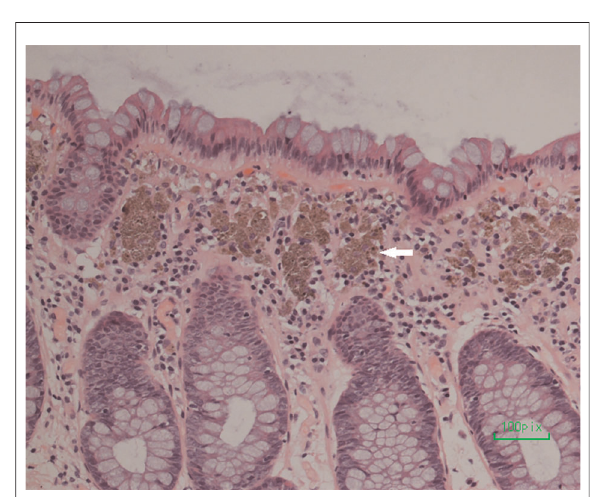
FIGURE 3 Biopsy of the dark brown intestinal mucosa showed that there were different degrees of macrophage deposition in the lamina propria interstitial cells of the colonic mucosa (white arrowhead), but the epithelial cell layer was